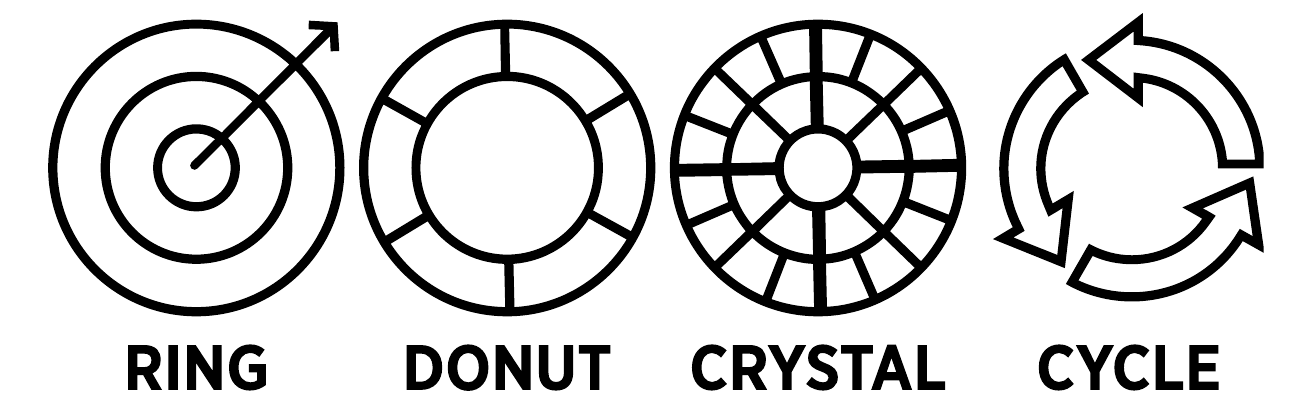
Figure 2. Circular chart types.